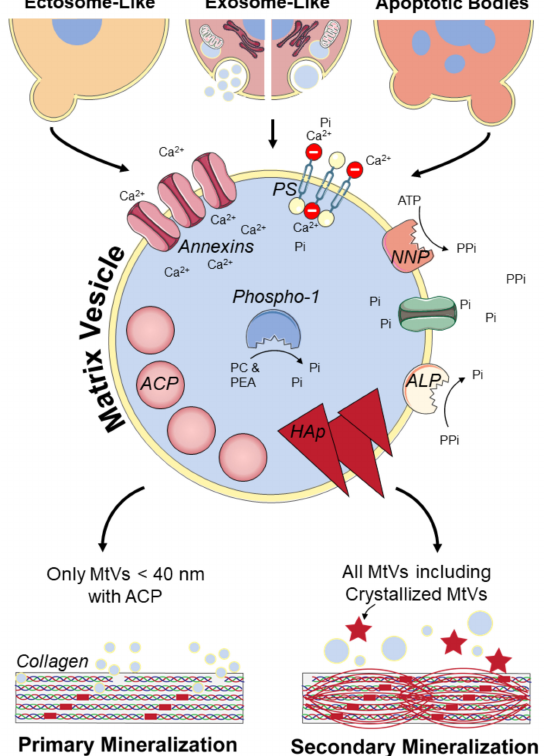
Figure 2. Possible MtV biogenesis pathways and collagen mineralization mechanisms. MtV, matrix vesicle; ALP, alkaline phosphatase; NNP, nucleotide pyrophosphatase; PS, phosphatidylserine; ACP, amorphous calcium phosphate; HAp, hydroxyapatite. The figure was modified from Servier Medical Art, licensed under a Creative Common Attribution 3.0 Generic License. (http://smart.servier.com/, accessed on 20 January